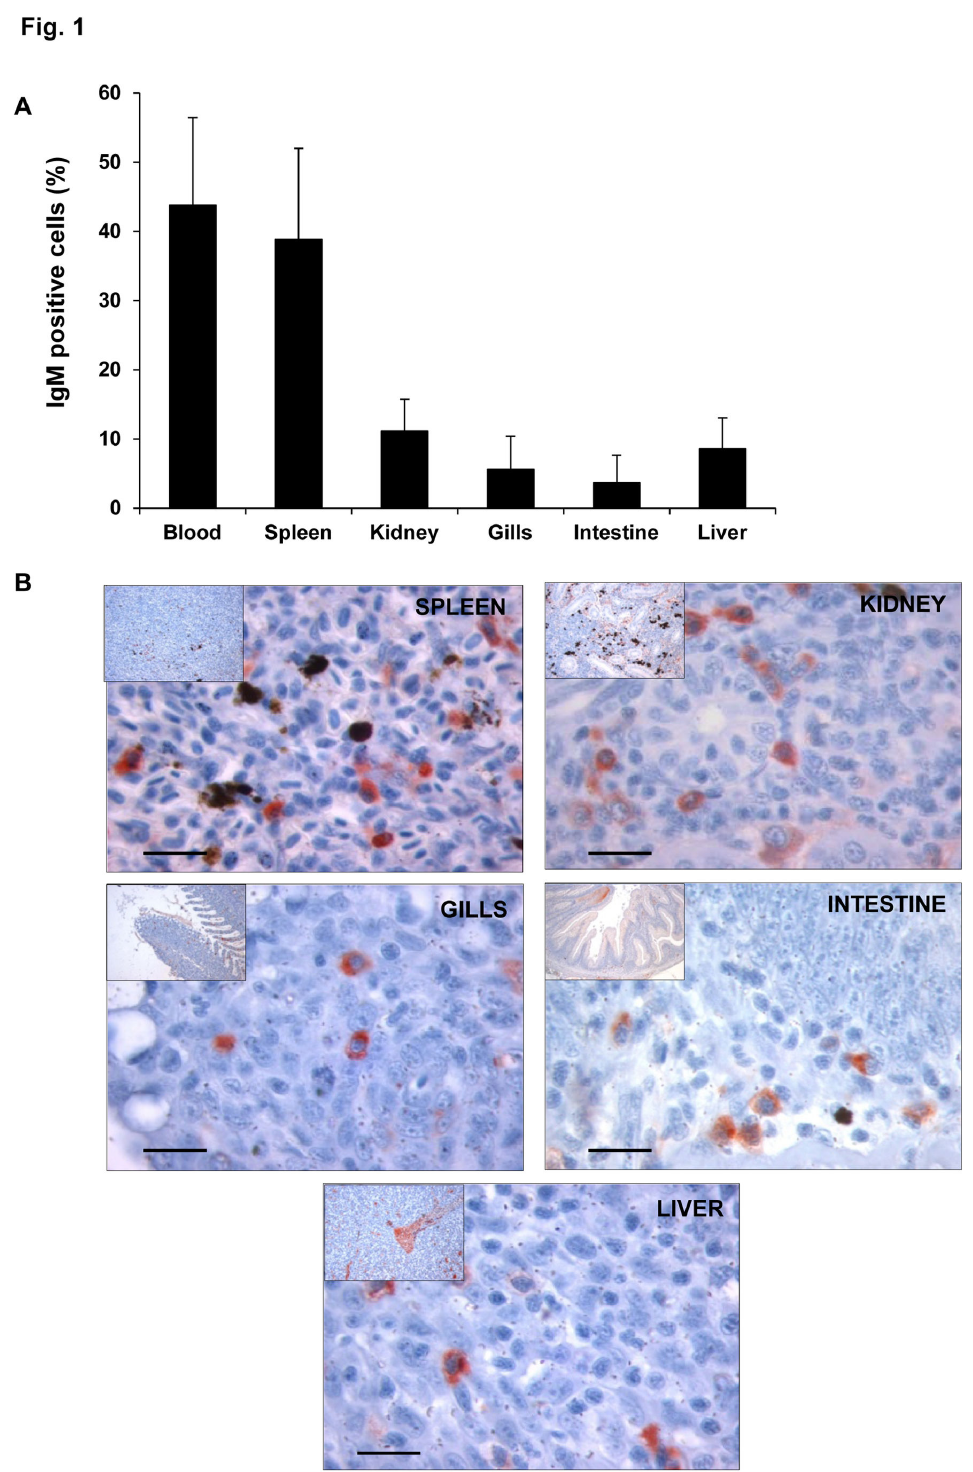
Figure 1. Location of IgM + cells in diverse rainbow trout tissues. A. Mean percentage of IgM + cells found in different trout tissues ± SD. Average from 6 to 11 individuals estimated by flow cytometry. B. Immunohistochemical detection of trout IgM + cells in diverse trout tissues. The figures show a magnification image and an insert figure of the general location in which the detail was observed. Positive IgM detection is observed in red. Bar: 100 µm. doi: 10.1371/journal.pone.0082737.g001 PLOS ONE |